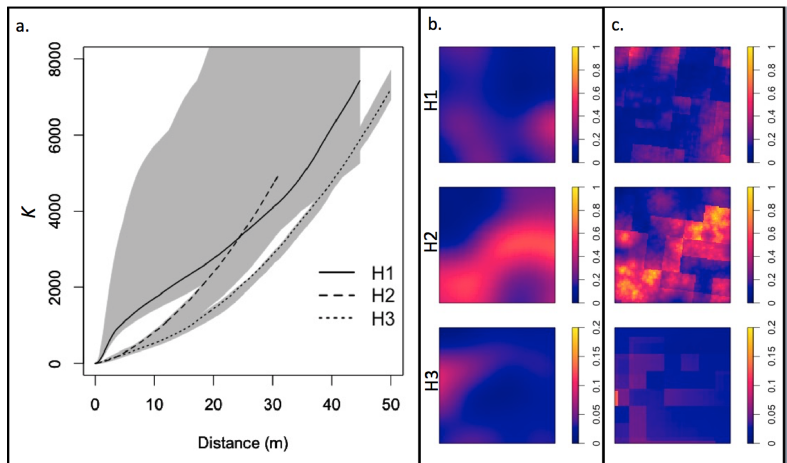
Figure 5. ( a ) Post-fire regeneration density in relation to the Neyman–Scott point process model for plots (H1, H2, and H3) in the Hayman Fire. Observed data (black lines) were within the bounds of the simulated envelope for the Neyman–Scott model (shaded region), confirming that the data were spatially clumped at all distances. Comparing ( b ) observed and ( c ) predicted densities shows that the model is capturing general trends in regeneration density. Table 4. Estimates of regeneration density (stems m − 2 ) regression coefficients, standard errors (S.E.) and p -values for the Hayman Fire plot level point pattern models. The distance to the nearest residual tree, burn severity, topographic wetness index (TWI), elevation, and the distance to the nearest aspen (POTR) cluster were important drivers of post-fire regeneration